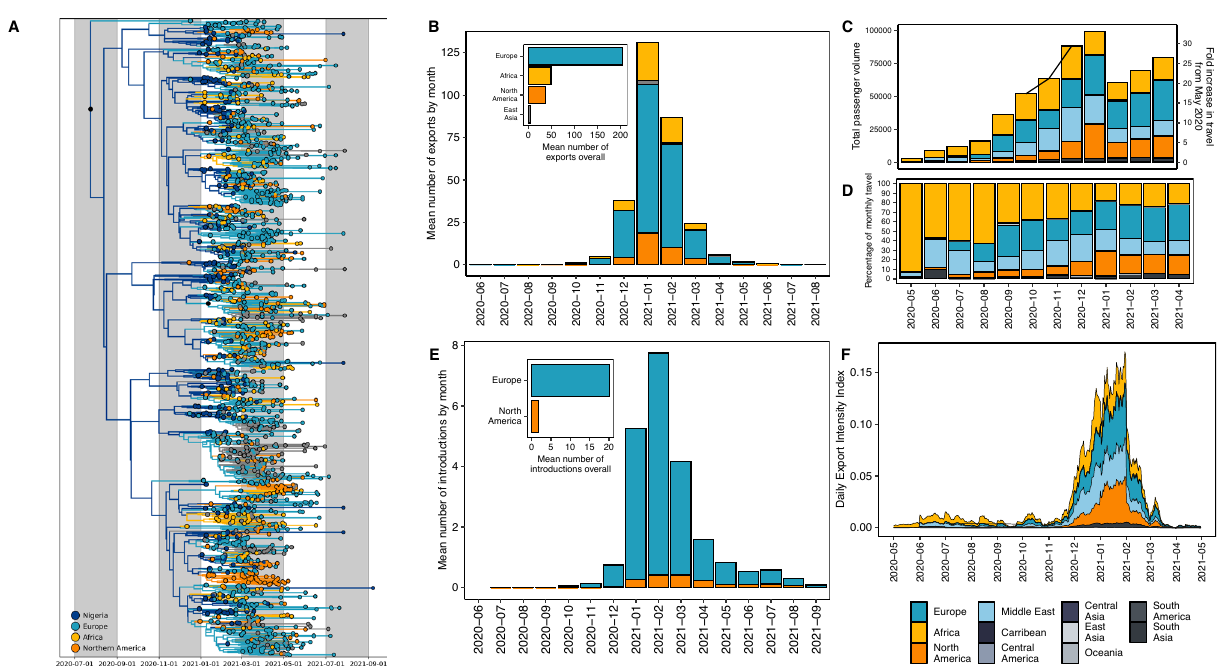
Fig.3|BayesianphylogeographicreconstructionoftheB.1.525variant.A Time- resolvedB.1.525phylogeny.Branchesarecolouredbyregion-levelgeographicstate reconstruction. Locations with negligible contributions have been grouped and annotated in grey. Internal nodes annotated with black points represent posterior support > 0.75. B Mean number of exports (Markov jumps) of B.1.525 from Nigeria to destination regions, binned by month. Mean number of exports overall (inset).